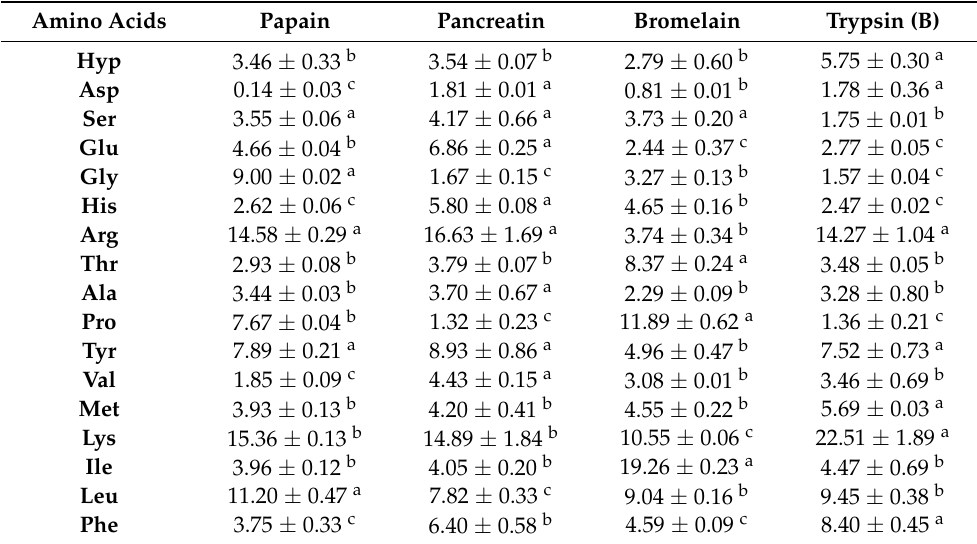
Table 2. Free amino acid distribution of the hydrolysates obtained by enzymatic hydrolysis of calf fleshing